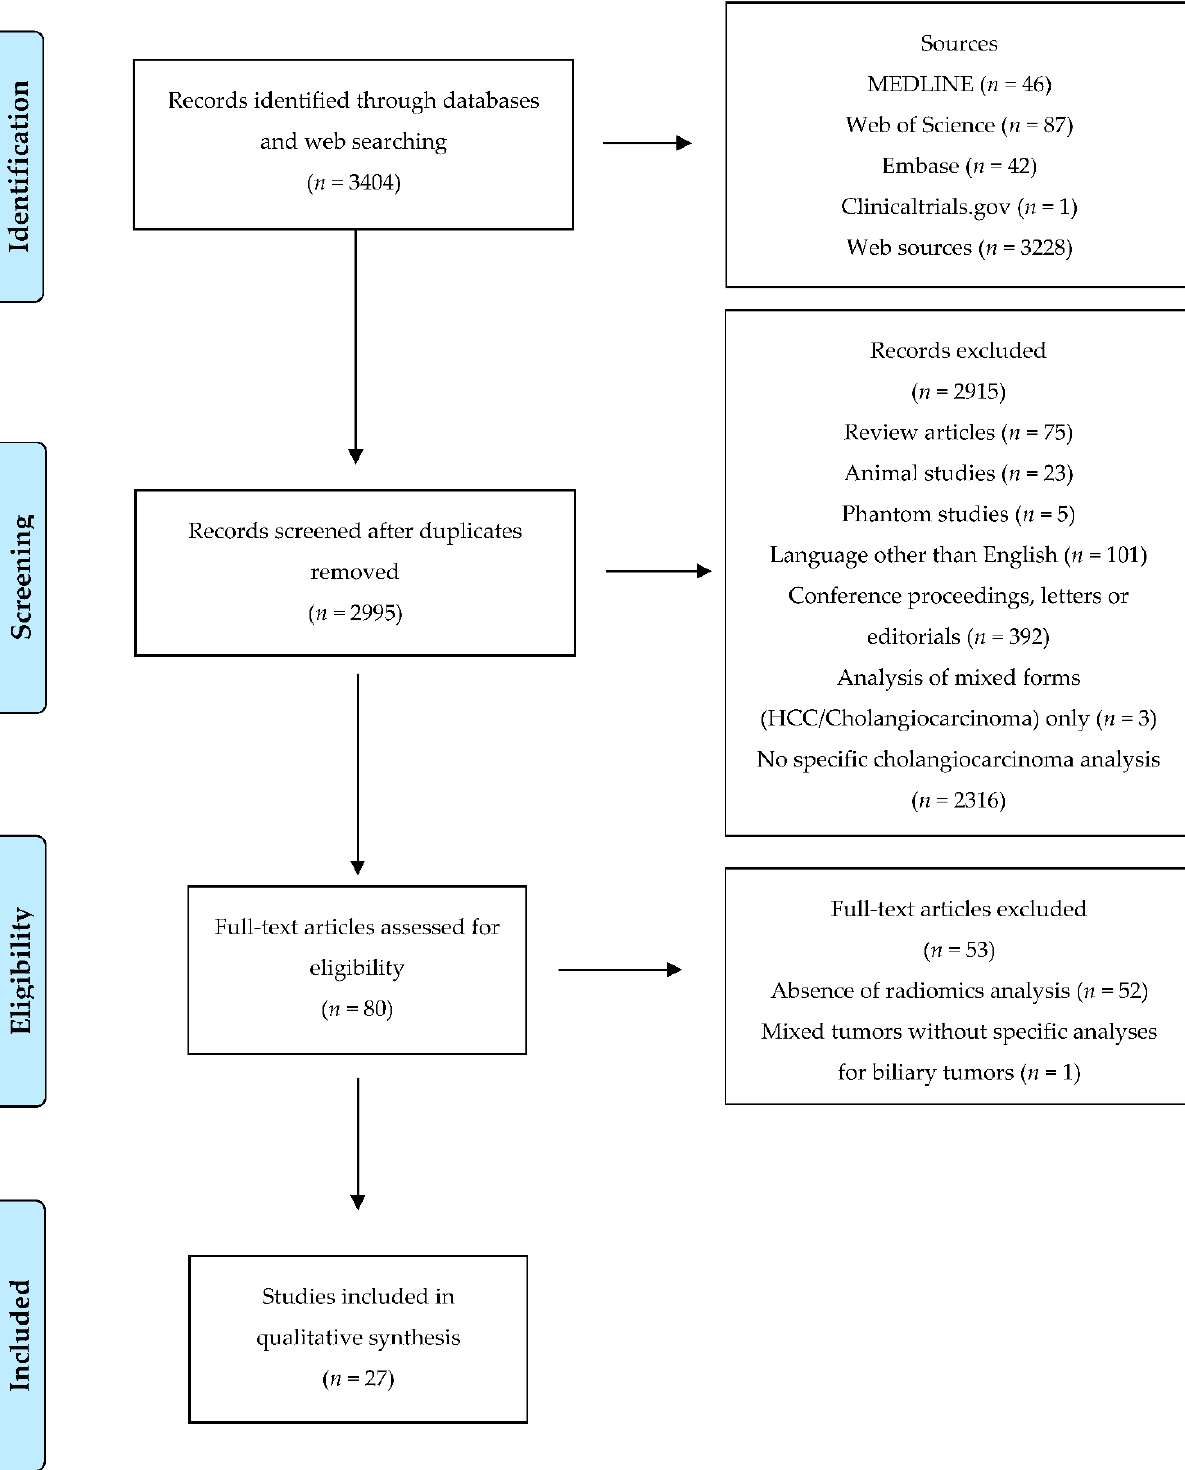
Figure 1. Prisma Figure 1. Prisma flowchart.